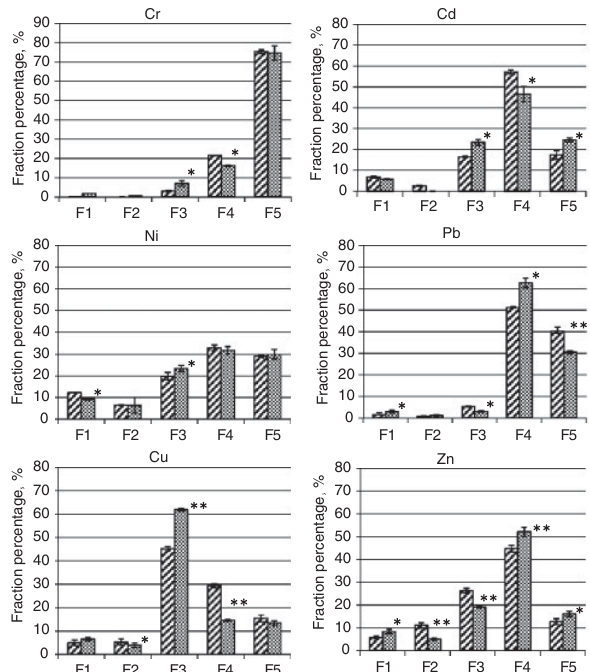
Fig. 1. The chemical fractions (F1 (cid:2) F5) of the heavy metals in the sewage sludge: (cid:2) before anaerobical treatment; (cid:2) after anaerobical